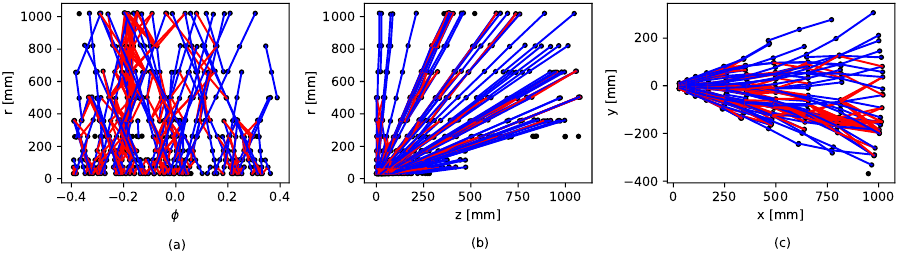
Figure 2. 1 of 16 subgraphs created from a single event. (a,b) are subgraphs in cylindrical coordinates and (c) is a subgraph in Cartesian coordinates. Red represents Ground Truth, while Blue shows Fake edges created using loose